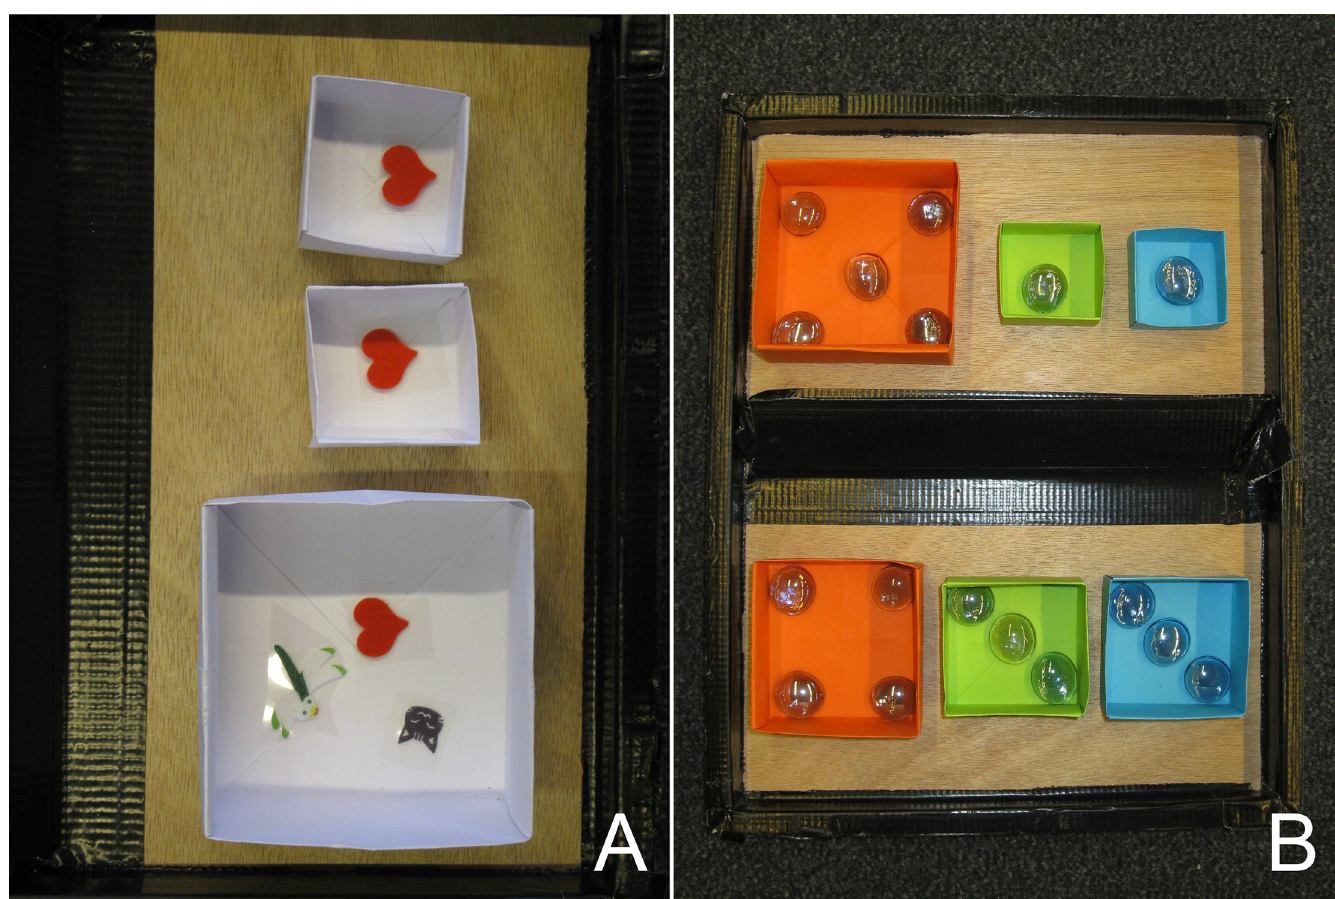
Fig 2. Material and set-up. (a) Boxes with reward stickers in the procedure choice game and (b) glass stones in the distribution choice game. The size of the boxes reflected the number of rewards they